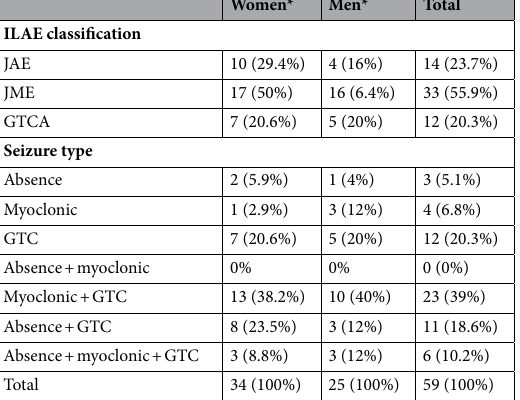
Table 2. Seizure type classified by and ILAE IGE syndrome. ILAE International League Against Epilepsy, JAE Juvenile Absence Epilepsy, JME Juvenile Myoclonic Epilepsy, CGTA Generalized Tonic Clonic Alone, GTC Generalized Tonic Clonic. *There was no significant difference based on gender for any seizure type prevalence ( p >